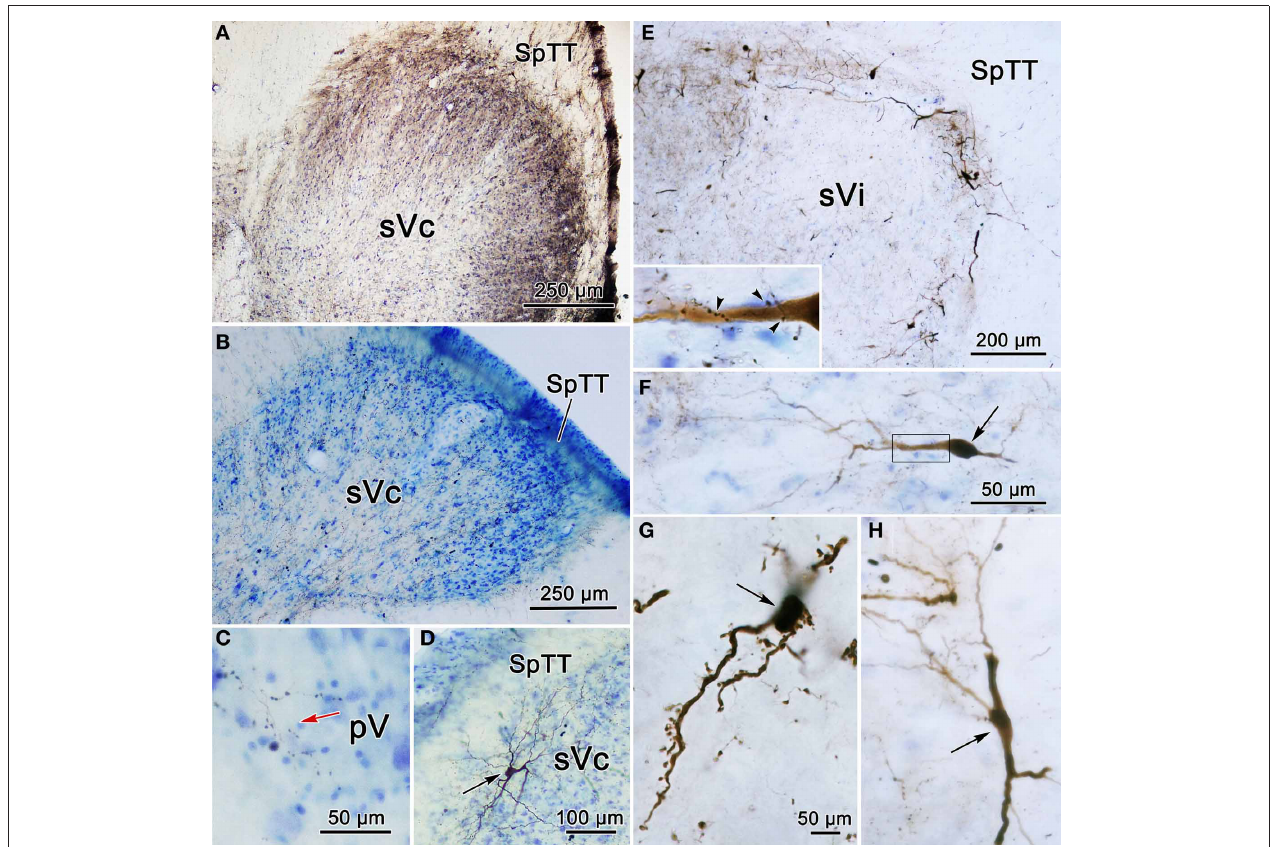
FIGURE 12 | Photomicrographsoflabeledneurons(arrows) andterminals fromaBDAinjectionsintosVcareshown(A–D)andsViareshownin(D,E). (A) IsalowmagnificationofcontralateralsVcafter alargeinjectionin thespinal portionof sVc. (B) Is a low magnificationof contralateral sVc after a small injectionin thespinalportionofsVc( Figure 11A 4 – 6 ). (C) Showsterminalsin pV (redarrow)fromthesamecase. (D) Showsaretrogradelylabeledcell(arrow)in lamina I of ipsilateral sVcventrolateral to the injection site. (E) is a low magnificationview that revealsthe distributionof labeledcells and axonsis